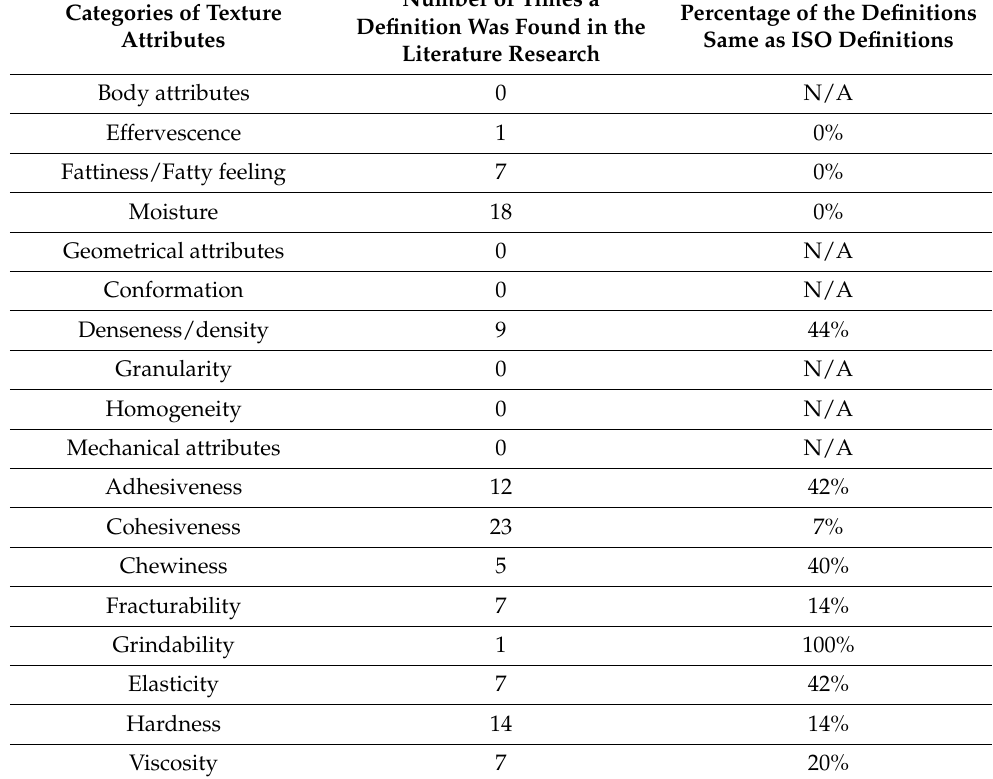
Table 5. Number of times definition found for each category of texture attributes and percentage same as ISO 5492:2008 standard